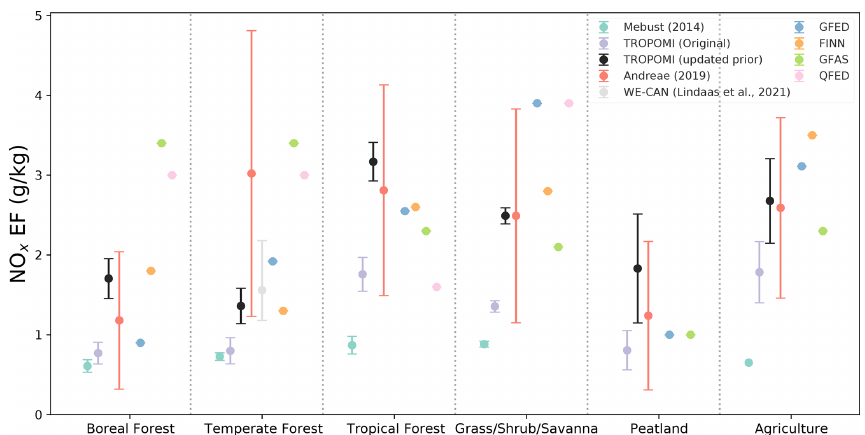
Figure 4. Comparison of the TROPOMI-derived NO x emission factors with previous studies and those used in global biomass burning emission inventories. We include two estimates of NO x emission factors: one using the original TROPOMI NO 2 (purple) and the other with updated a priori profile for AMF calculation (black). The error bars of TROPOMI NO x EFs represent 95% CI calculated based on Student’s t -distribution test. The red dots show the mean NO x EFs reported in previous studies compiled by Andreae (2019), and the error bars represent the standard deviation. The error bars of Mebust and Cohen (2014) are calculated using nonparametric bootstrap resampling. The error bars of Lindaas et al. (2021) indicate the overall uncertainty of